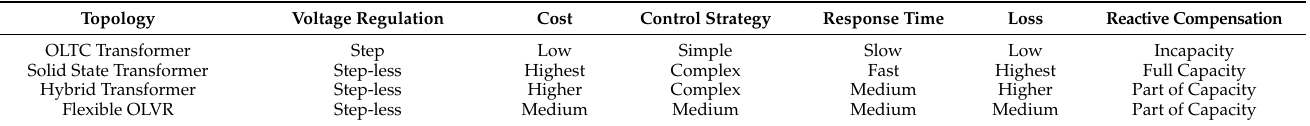
Table 1. Performance comparison table of the proposed structure and existing schemes.